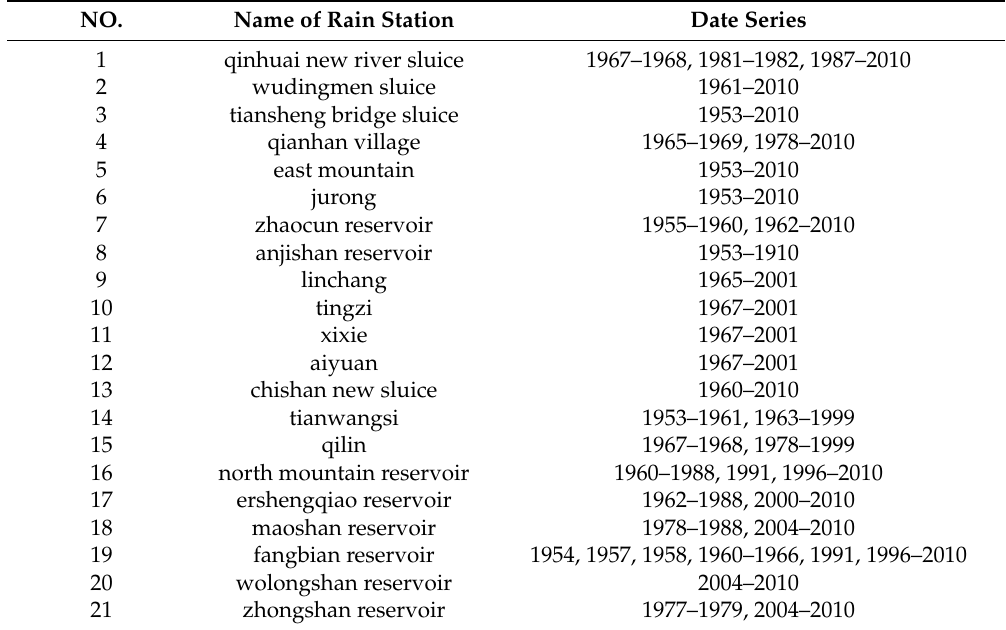
Table 1. Daily precipitation data